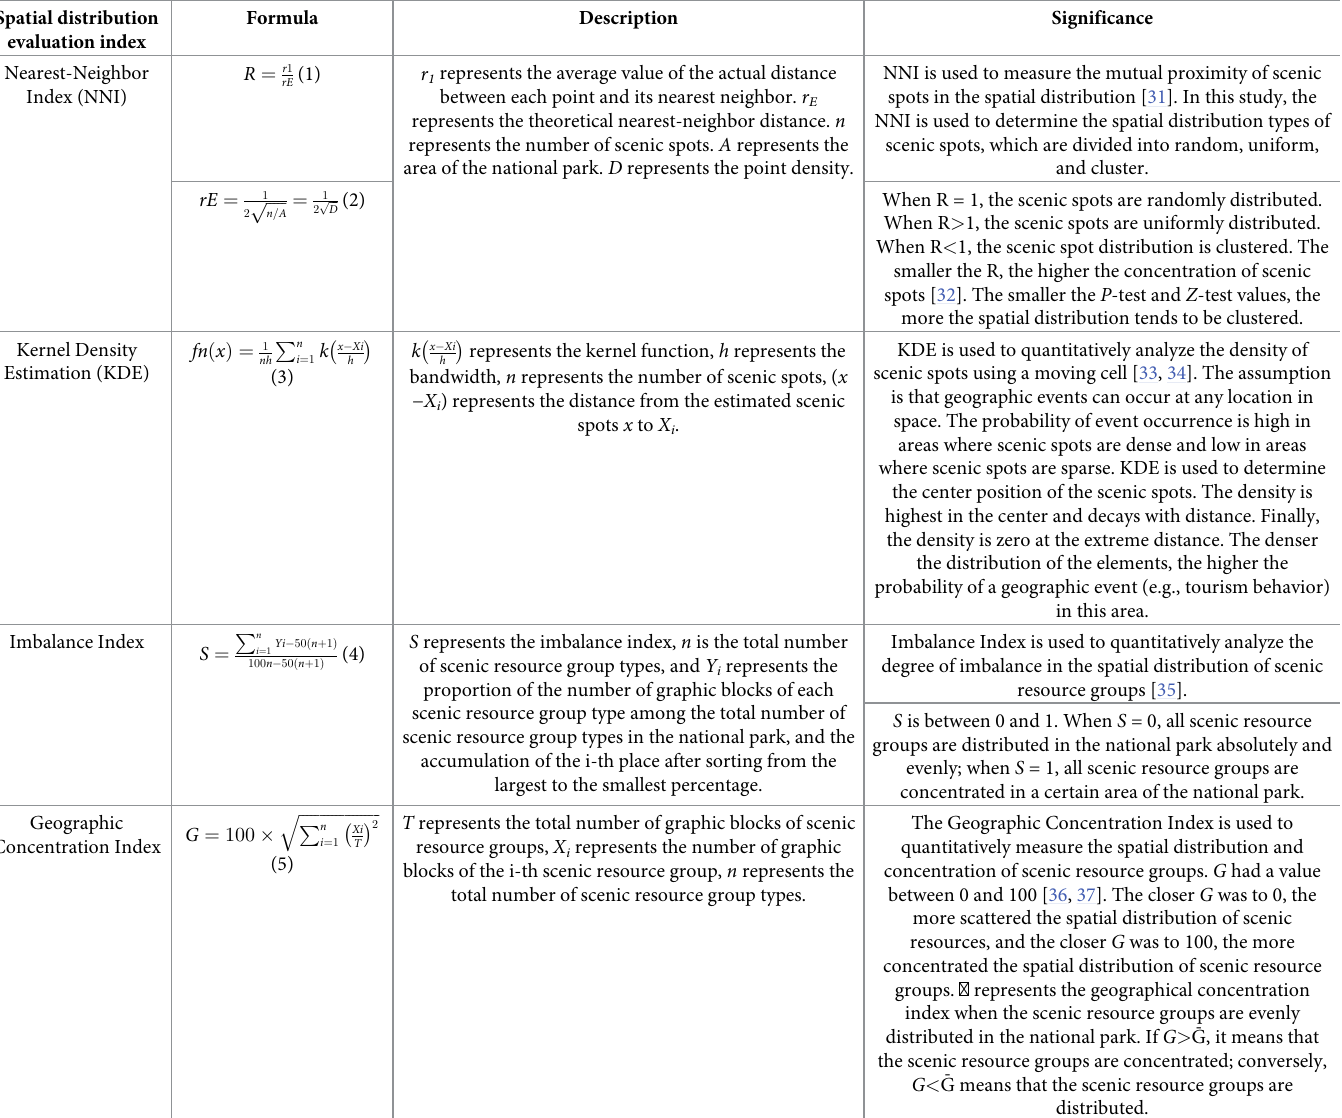
Table 2. Spatial distribution evaluation